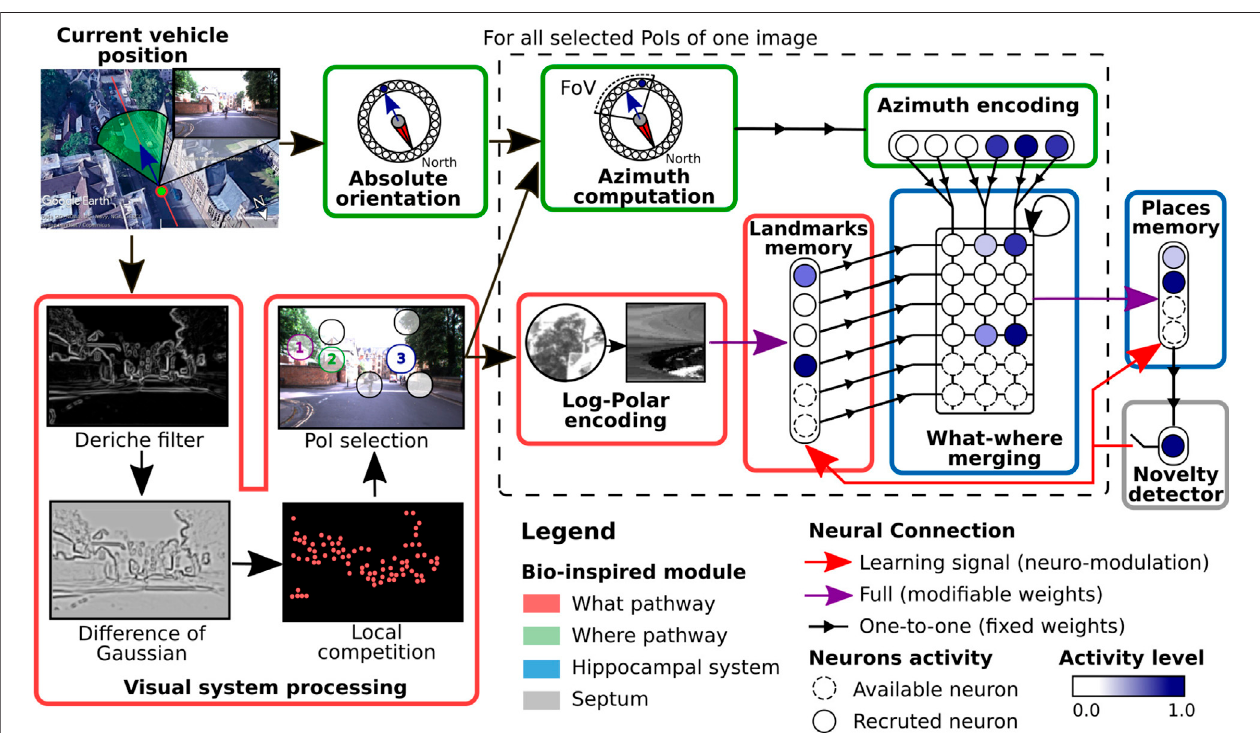
FIGURE 3 | CompleteschemeoftheLog-PolarMax-Pi(LPMP)model.This fi gureillustrateshowtheLPMPmodelbuildsaplacerepresentationfromoneimageofaroute sequence.Inthisneuralmodel,aplaceisde fi nedasavisuospatialpatternspeci fi cofthecurrentlocationandresultsfromthemergingoftwopiecesofinformation:theimage I and thecompassofthevehicle.Tocharacterizeavisualscene,LPMPdetects N p pointsofinterest(PoIs)fromanimage.Subsequently,inanattentionalloop,thesystemsequentially extracts image patches centered on each PoI, computes a feature vector ( via a log-polar transform), and learns this pattern in a fi rst neural winner memory (landmark memory). In parallel, their spatial orientation (according to a given absolute reference) is computed in the azimuth computation block and mapped in a neural layer (azimuth encoding).Then,bothpiecesofinformationarethenmergedinaneuralMax-Pilayer(what – wheremerging).WhenalltheselectedPoIsareprocessed,theresultingactivitypattern oftheMax-Pilayerisrepresentativeofthespatialcon fi gurationofthelandmarksandisthereforecharacteristicofthecorrespondingplace.Finally,thispatternisstoredinasecond